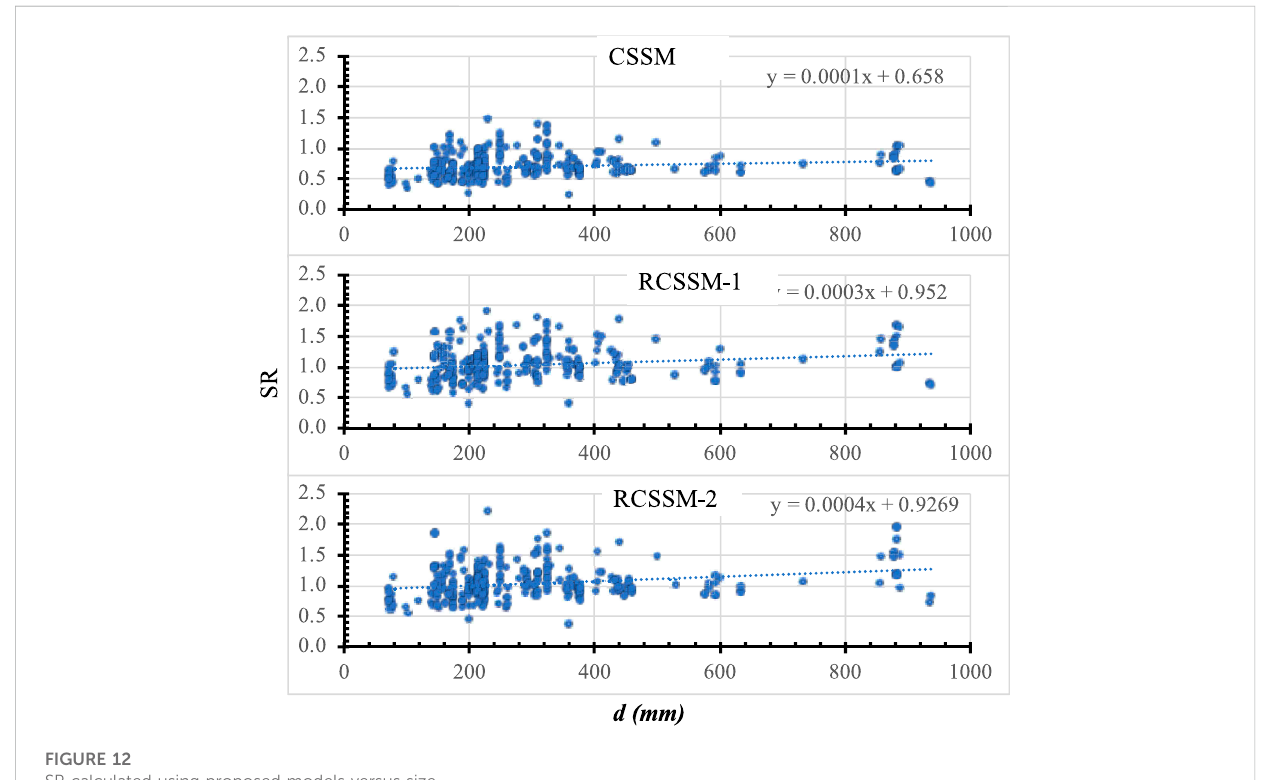
FIGURE 12 SR calculated using proposed models versus size.